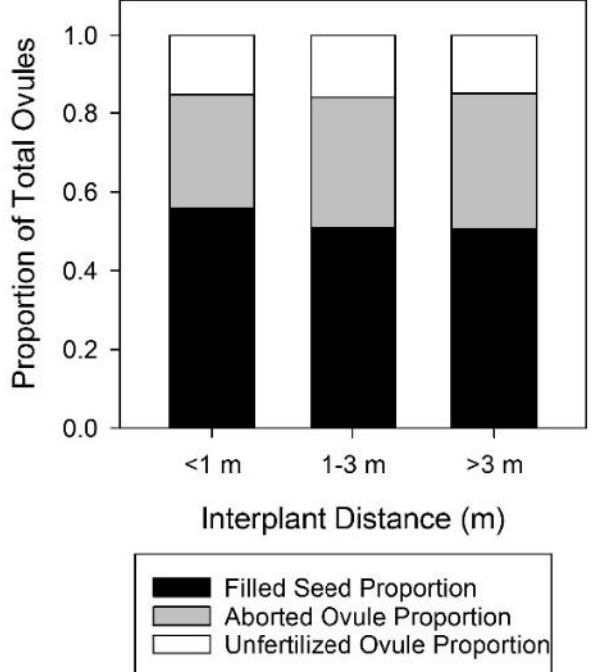
Figure 7. The effect of interplant distance on ovule fate averaged across three dwarf bear poppy populations in 2019. There was no significant effect of interplant distance on fertilization success, but the negative effect on filled seed proportion was significant. Note that interplant distances are binned into categories for ease of interpretation but that interplant distance was a continuous variable in the analysis See Appendix C for full statistical analysis.